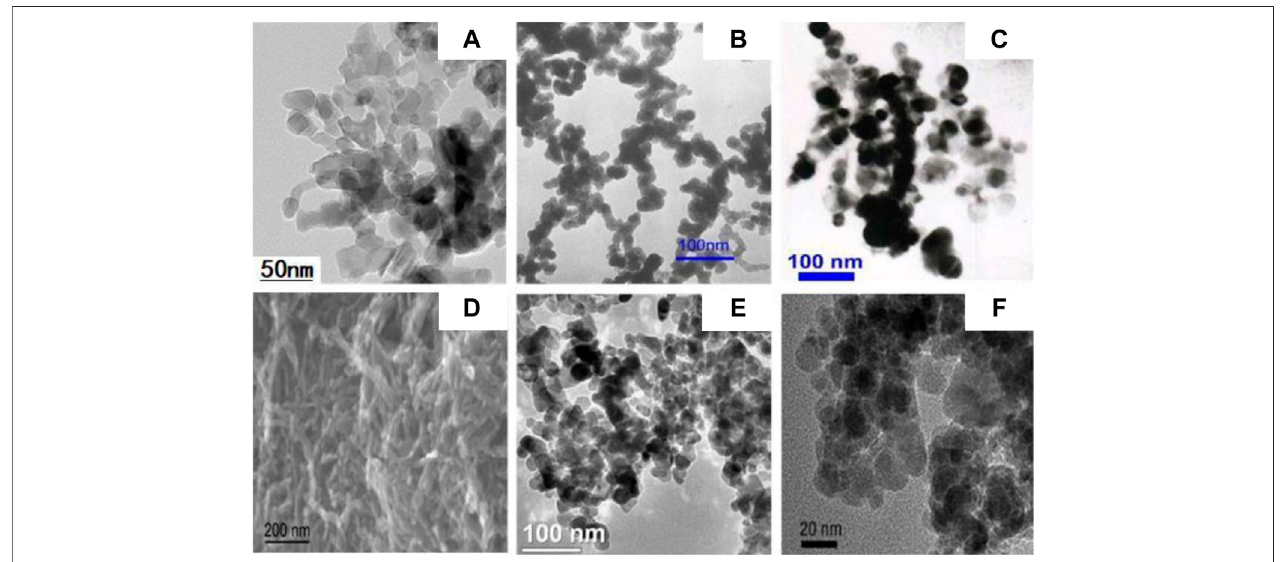
FIGURE 2 | SEM images of nanoparticles (A) Al 2 O 3 (Zheng et al., 2020b), (B) SiC (Zheng et al., 2020b), (C) CuO (Zheng et al., 2020b), and (D) CNTs (Wang et al., 2021a) and TEM images of (E) ZnO (Zheng et al., 2020a) and (F) Fe 3 O 4 (Wang et al.,